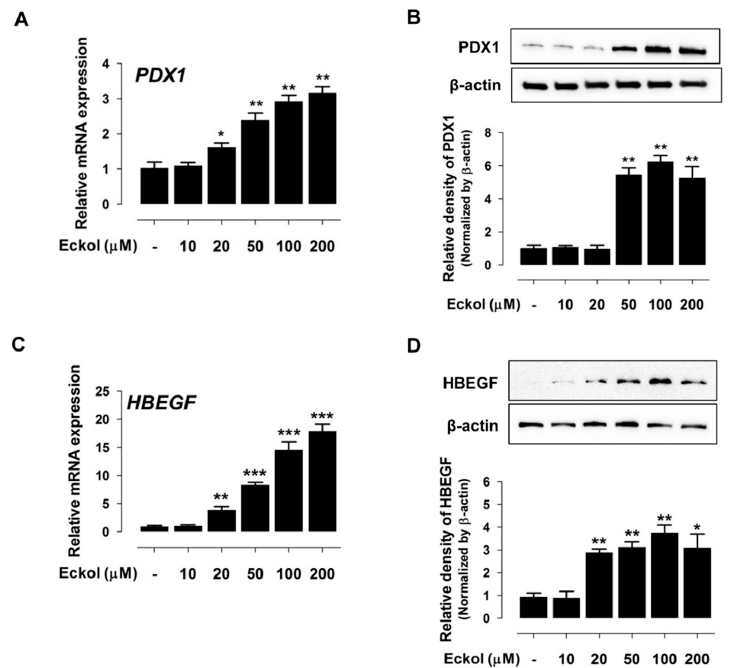
Figure 3. Eckol induces PDX1 and HBEGF expression. PDX1 mRNA ( A ) and protein ( B ) expression in cells treated with eckol at di ff erent concentrations (0 µ M, 10 µ M, 20 µ M, 50 µ M, 100 µ M, and 200 µ M). HBEGF mRNA ( C ) and protein ( D ) expression in cells treated with various concentrations of eckol. Protein band intensity in the Western blot analysis was quantified using the threshold function of the ImageJ software. For qRT-PCR analysis, target gene expression levels were normalized to those of glyceraldehyde 3-phosphate dehydrogenase ( GAPDH ). Error bars indicate standard error of triplicate analyses. * p < 0.05, ** p < 0.01, *** p <